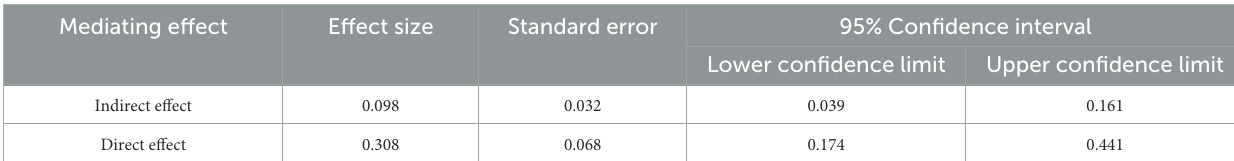
TABLE 6 Bootstrap test for mediating effect 2.